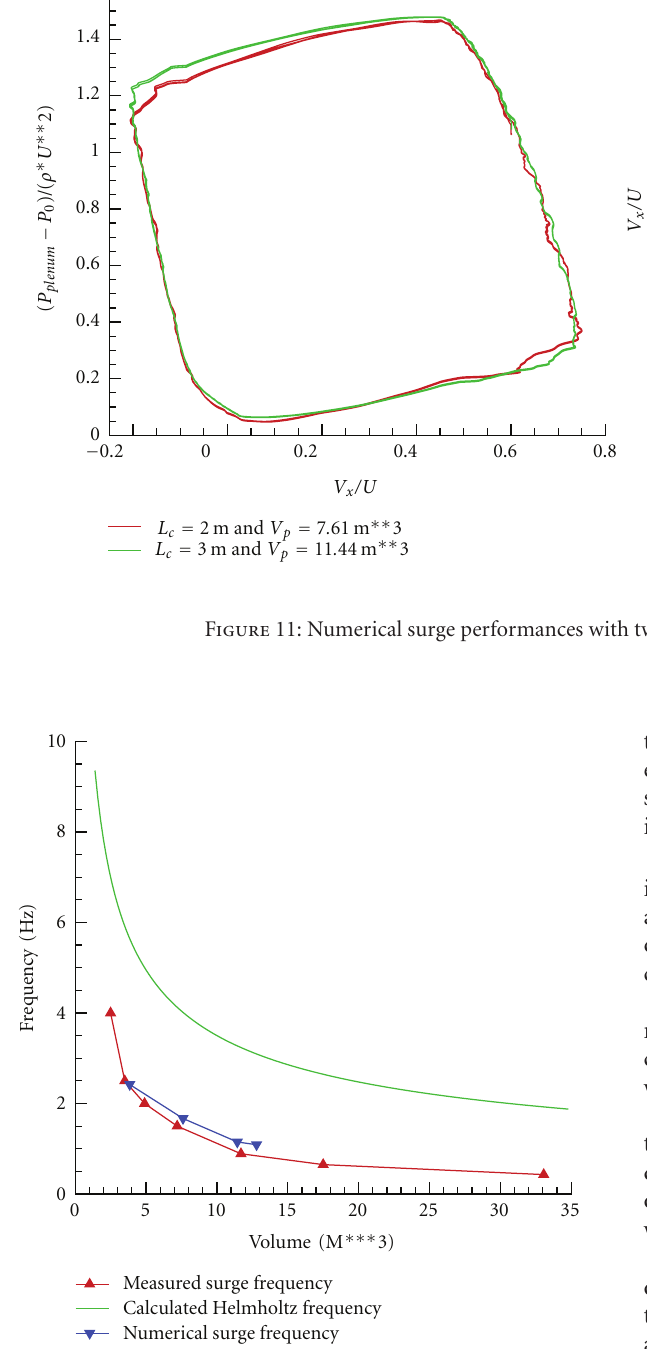
Figure 12: Experimental and numerical surge frequencies versus plenum volumes